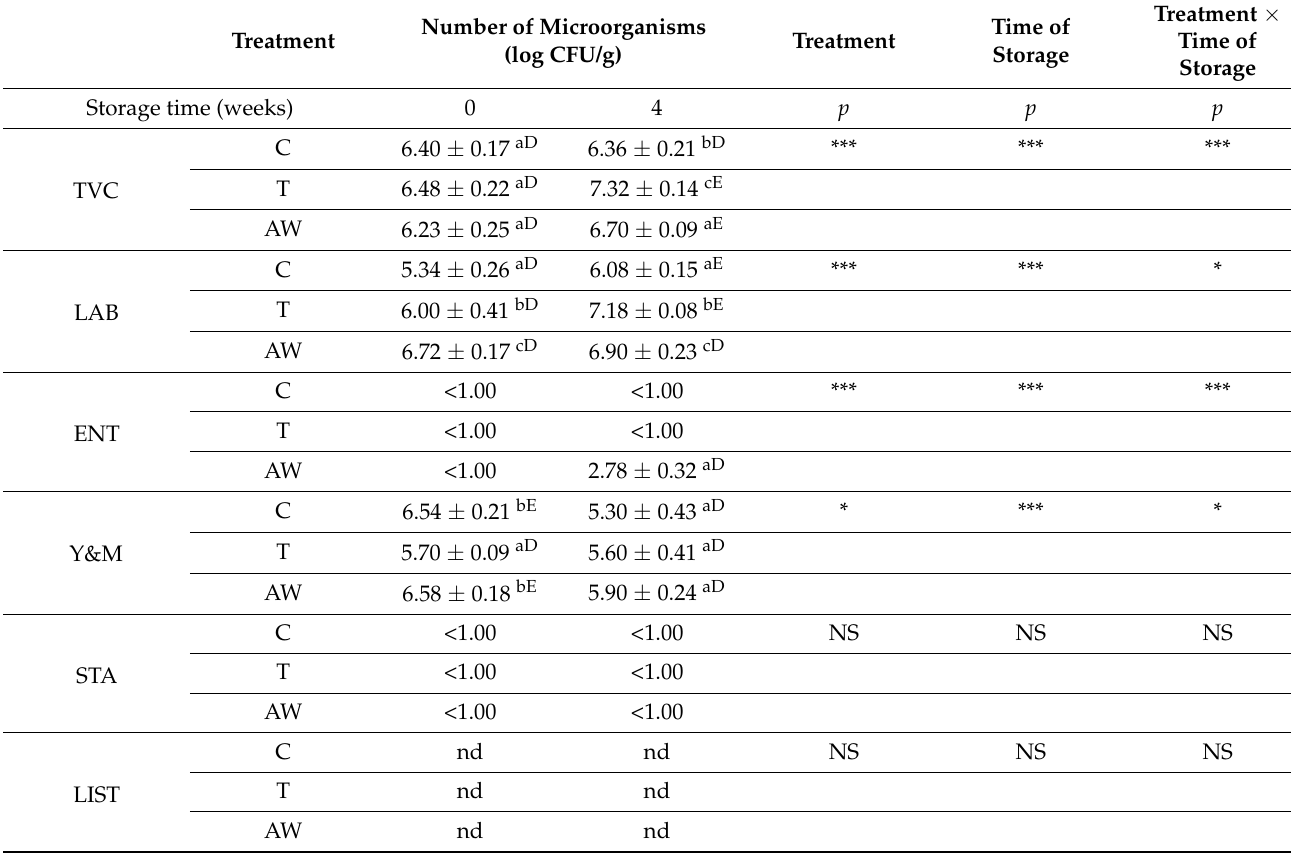
Table 2. Microbiological assessment of fermented pork bacon (means ± standard deviations). Number of Microorganisms Treatment (log CFU/g)